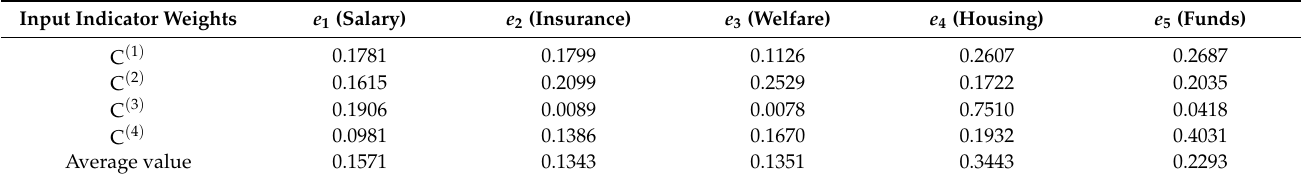
Table 3. Input indicator